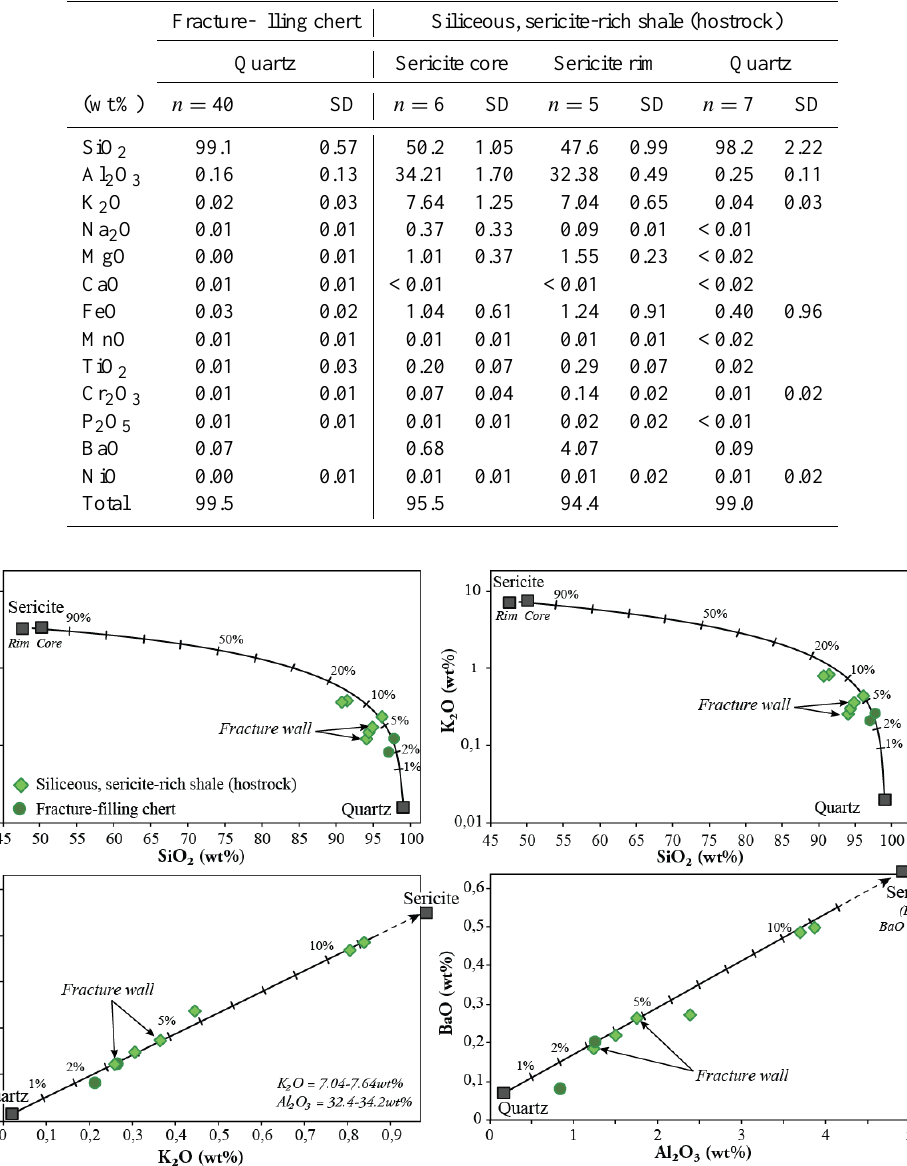
Figure 10. Major element correlation diagrams showing (1) decreasing aluminium and potassium concentrations with increasing SiO 2 , and (2) positive correlations between aluminium, potassium and barium. All samples fall on correlation lines between sericite and quartz, whose composition was obtained in situ by microprobe analysis. These data indicate that <4% of sericite is enough to control the fracture-filling chert